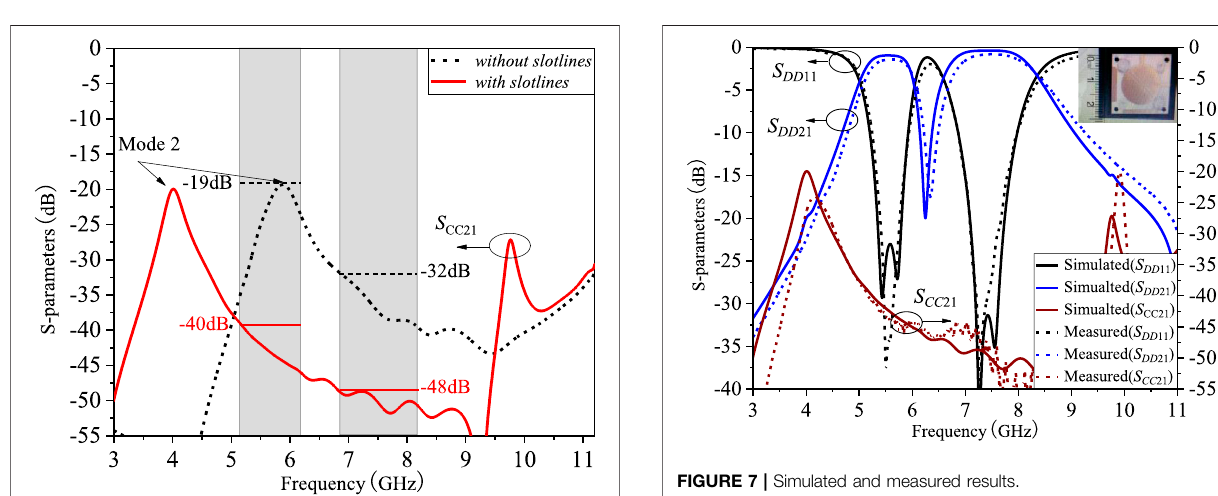
FIGURE 7 | Simulated and measured